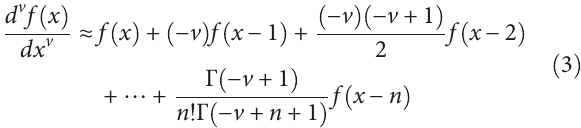
Table 1: Statistical result of EC